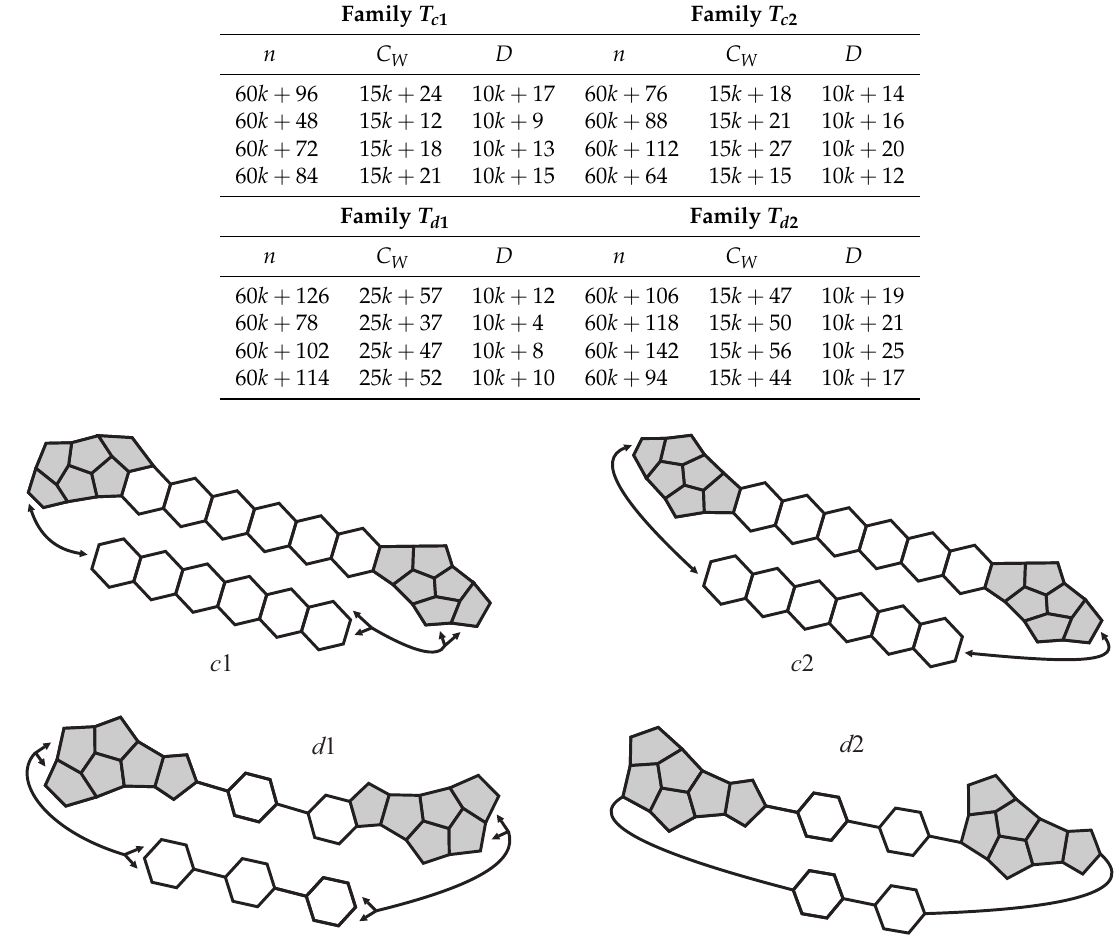
Figure 6. Mutual position of pentagonal parts for caps of types c and d